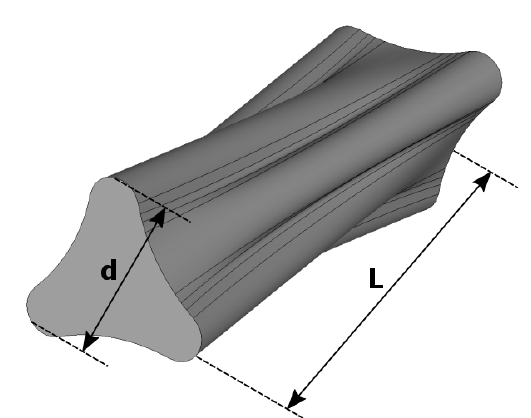
Figure 1. “Plasma-shaped” cavity with its main dimensions: diameter d and length L